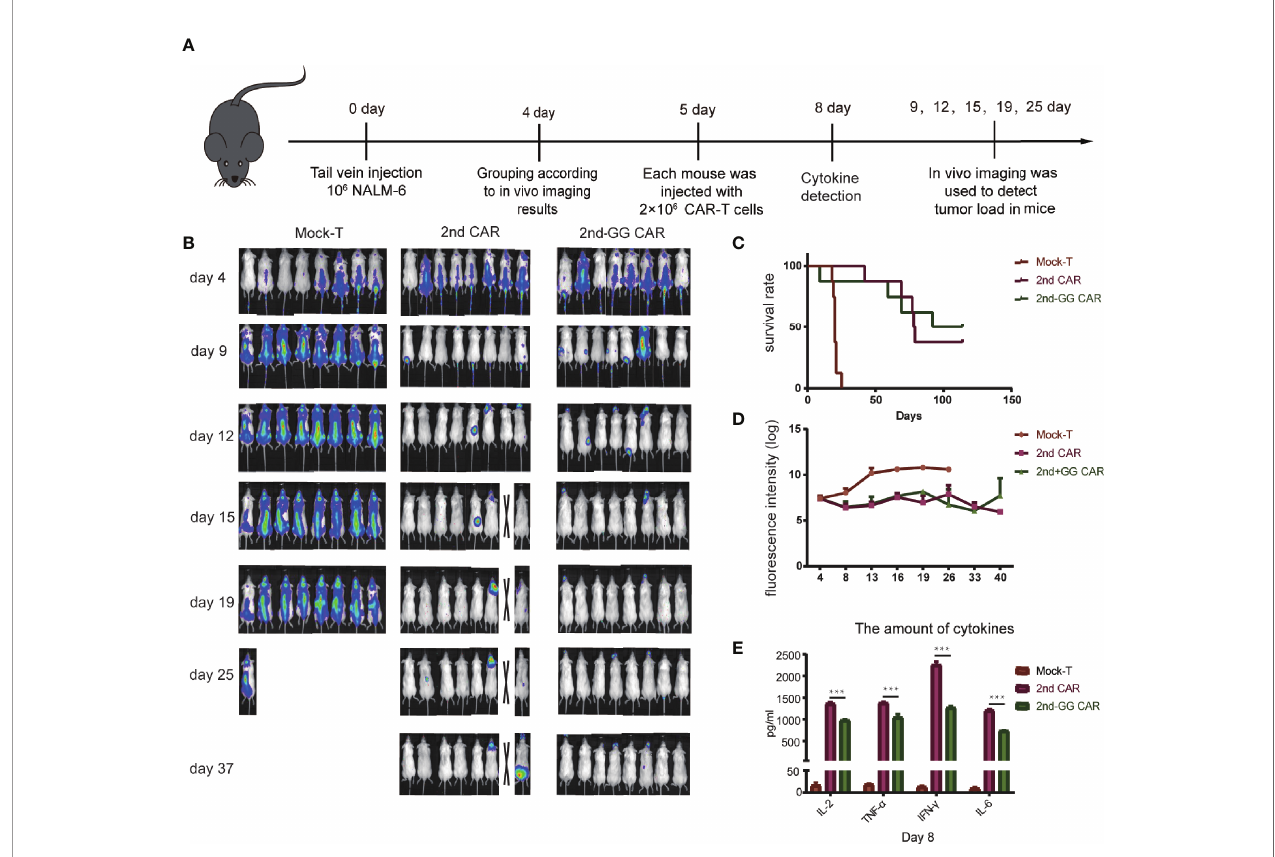
FIGURE 3 | The antitumor ef fi cacy and cytokines release of different CAR-T cells in moderate tumor load models. (A) Diagrammatic representations of the experimental procedures. (B) Representative bioluminescent images are shown. (C) Overall survival curves of NALM-6 -GFP-luc challenged mice (n = 8). (D) Tumor burden-total fl ux (log) for each mouse was quanti fi ed and averaged by group. (mean ± SEM) (E) On day 8, approximately 1,000 µL of blood were collected from the caudal vein of each mouse mixed to detect the concentration of human IL-2, TNF- a , IFN- g , and IL-6 using an ELISA-kit. (mean ± SD, n = 2). ***P <